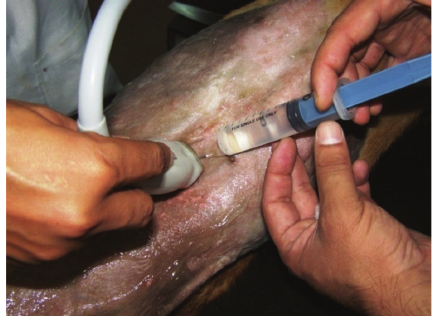
Figure 9: Ultrasound-guided percutaneous injection of positive contrast agent (Urografin 76%) in 3-year-old male Labrador Re- triever dog, suspected for portosystemic shunting.